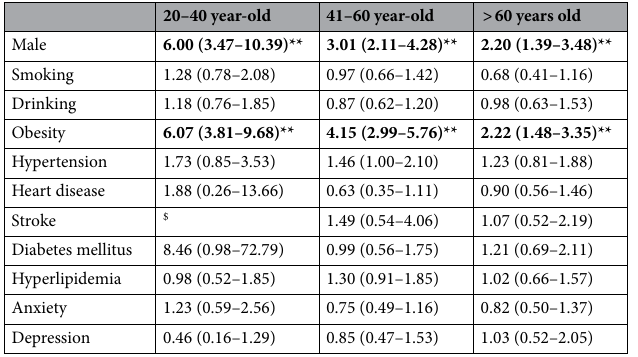
Table 3. Uni-variate logistic regression for odds ratio of characteristics related prevalence changes of OSA according to age. Significant values are given in bold. $ Not available, *p < 0.05, **p < 0.01.